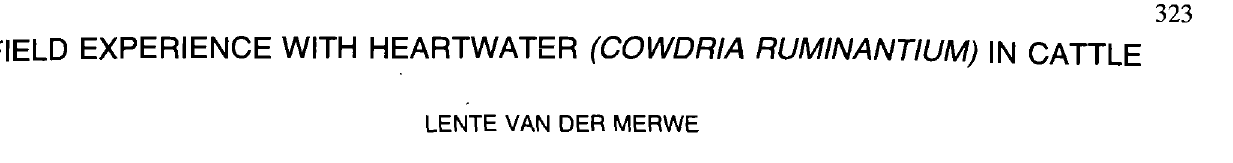
Table 1: REACTION TO HEARTWATER IMMUNISATION